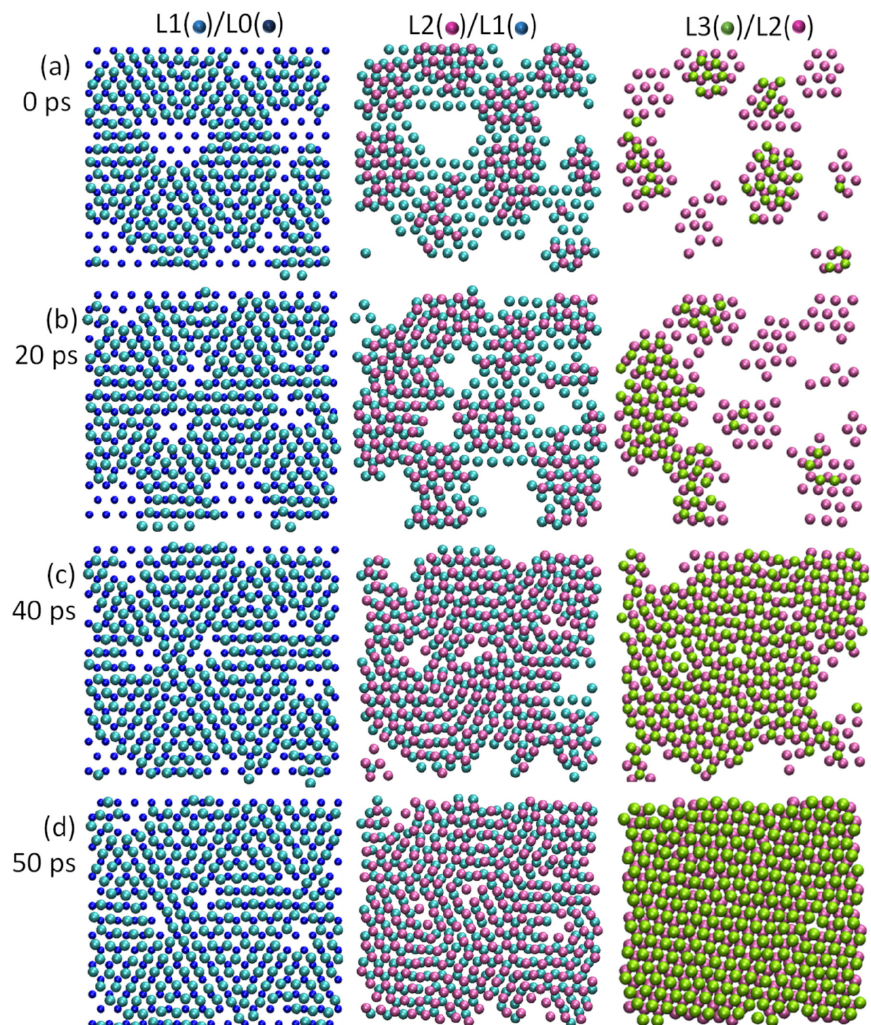
Figure 26. Structural templating as a mechanism for extending the ordered structure during nucle- ation process [11]. The simulation system: − 8% misfit, T n = 760 K. Atomic arrangements of the solid atoms at the interface as a function of time: ( a ) t = 0 ps, ( b ) 20 ps, ( c ) 40 ps and ( d ) 50 ps. Liquid atoms have been removed from snapshots using the local bond-order analysis. Starting from the precursor, nucleation proceeds layer-by-layer through structural